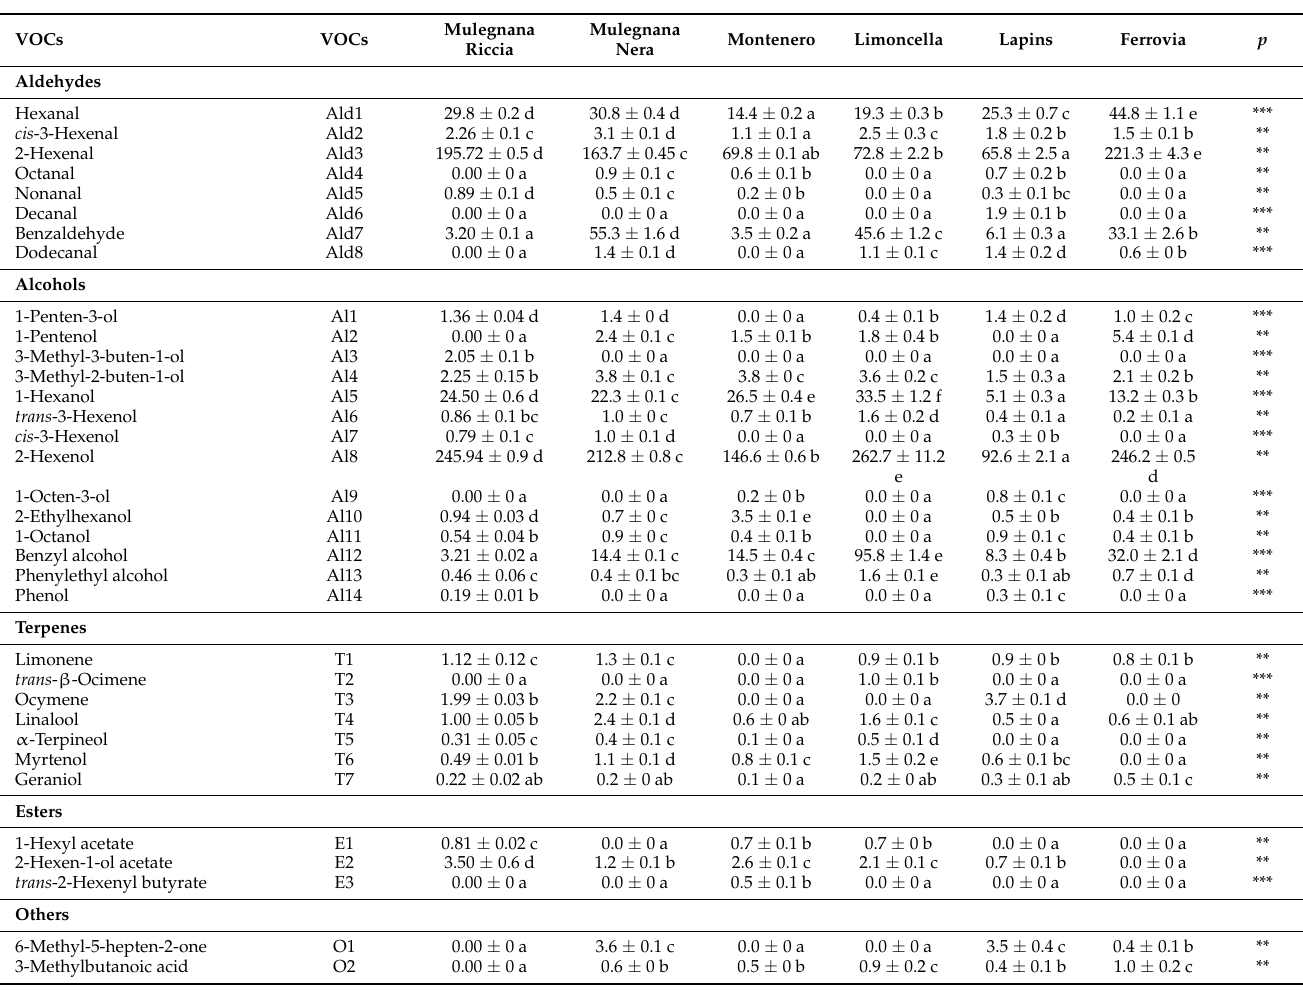
Table 2. One-way ANOVA of the volatile compounds detected by HS-SPME/GC-MS in the four sweet cherry accessions (Mulegnana Riccia, Mulegnana Nera, Montenero and Limoncella) compared to two standard cultivars (Lapins and Ferrovia). Data represent means ± SD. The same letters indicate non-significant differences (Tukey test) between accessions/cultivars. Significance: *** significant for p ≤ 0.001; ** significant for p ≤